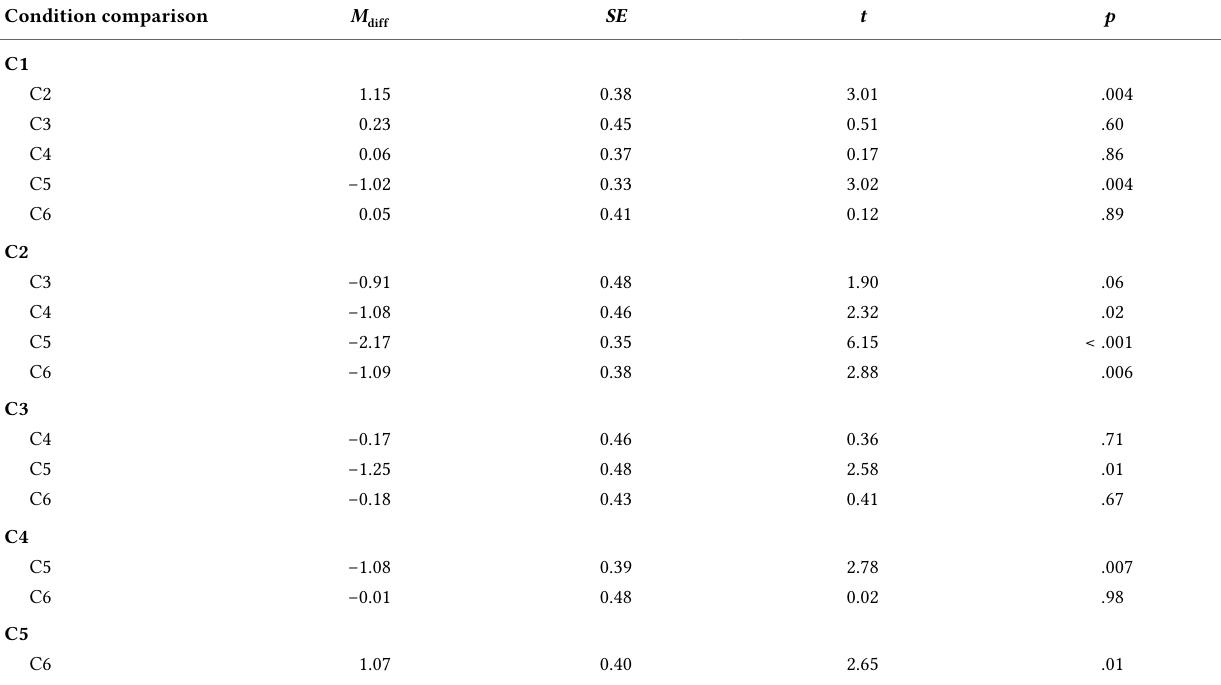
Post-Hoc Results Comparing the Memory Results (Collaposed Across the Two Memory Time Periods) Across the Six Experimental Conditions Condition comparison M SE diff